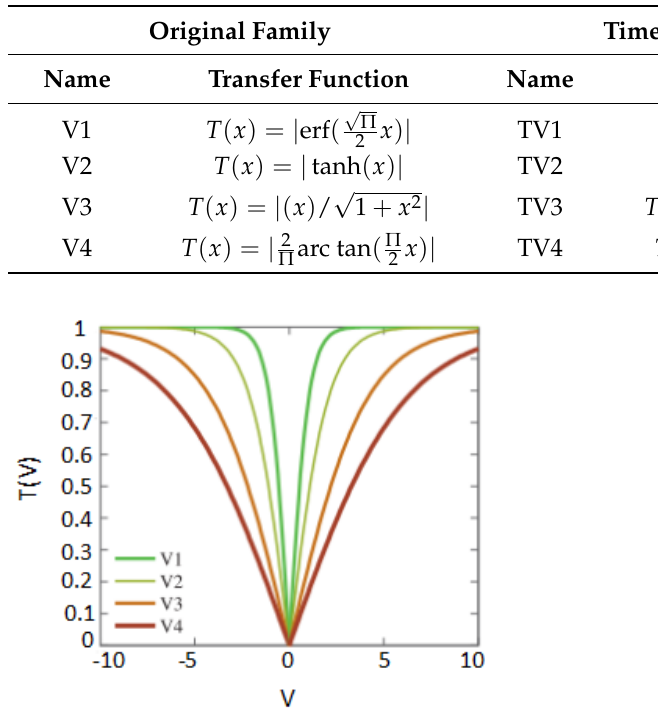
Table 1. Original and time-varying V-shaped transfer functions.